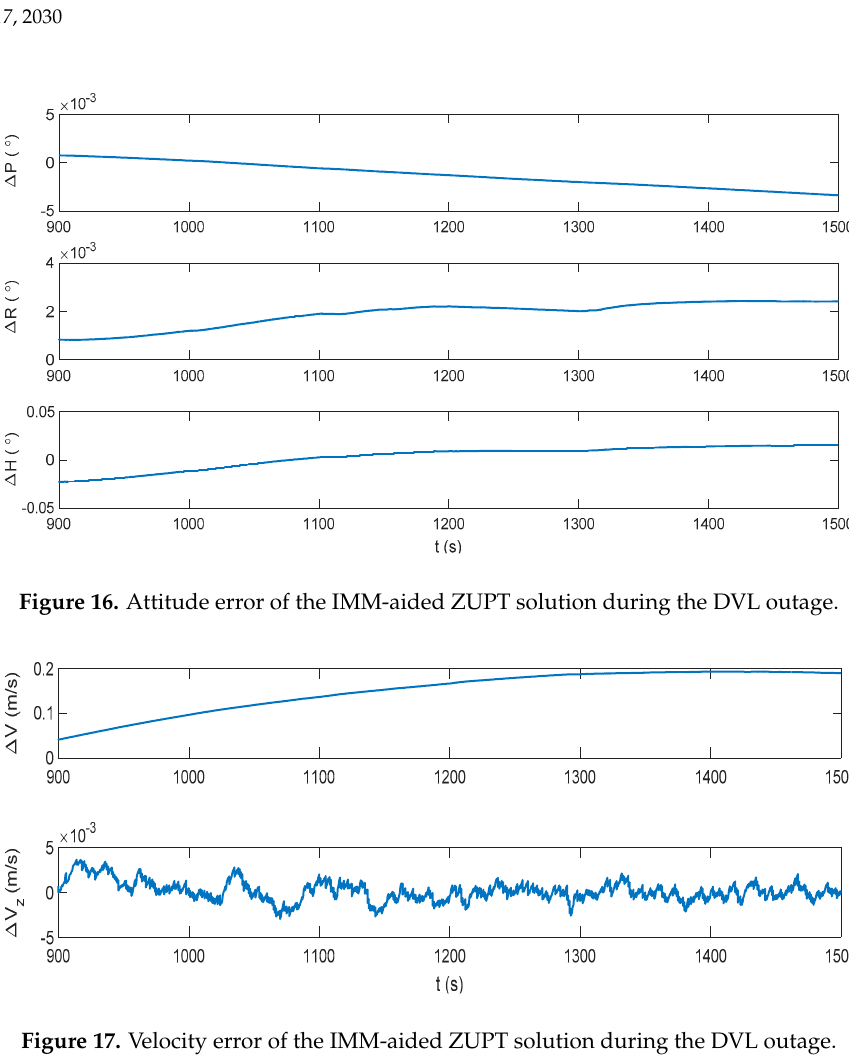
13 of 16 Figure 15. Position error of the pure INS solution during the DVL outage. The IMM-aided ZUPT solution is evaluated during DVL outage. The observation vector of the former INS/DVL model is set zero to represent the pure INS model. The longitudinal velocity observation element of former INS/ZUPT model is set zero as no DVL velocity is provided, while the observation element of the lateral velocity remains the difference between the lateral velocity calculated by INS and the zero velocity. The performance of the proposed algorithm during the DVL outage is shown in Figures 16–19. Compared to the pure INS mode, the proposed IMM-aided ZUPT solution can largely restrain the divergence of the velocity and position errors and improve the navigation accuracy. The velocity error is about 0.2 m/s at the end of the experiment, while the position error is 92.93 m after the 600 s DVL outage. The attitude error is similar to that of the pure INS mode. The model probability is shown in Figure 19. It can be seen that the proposed algorithm